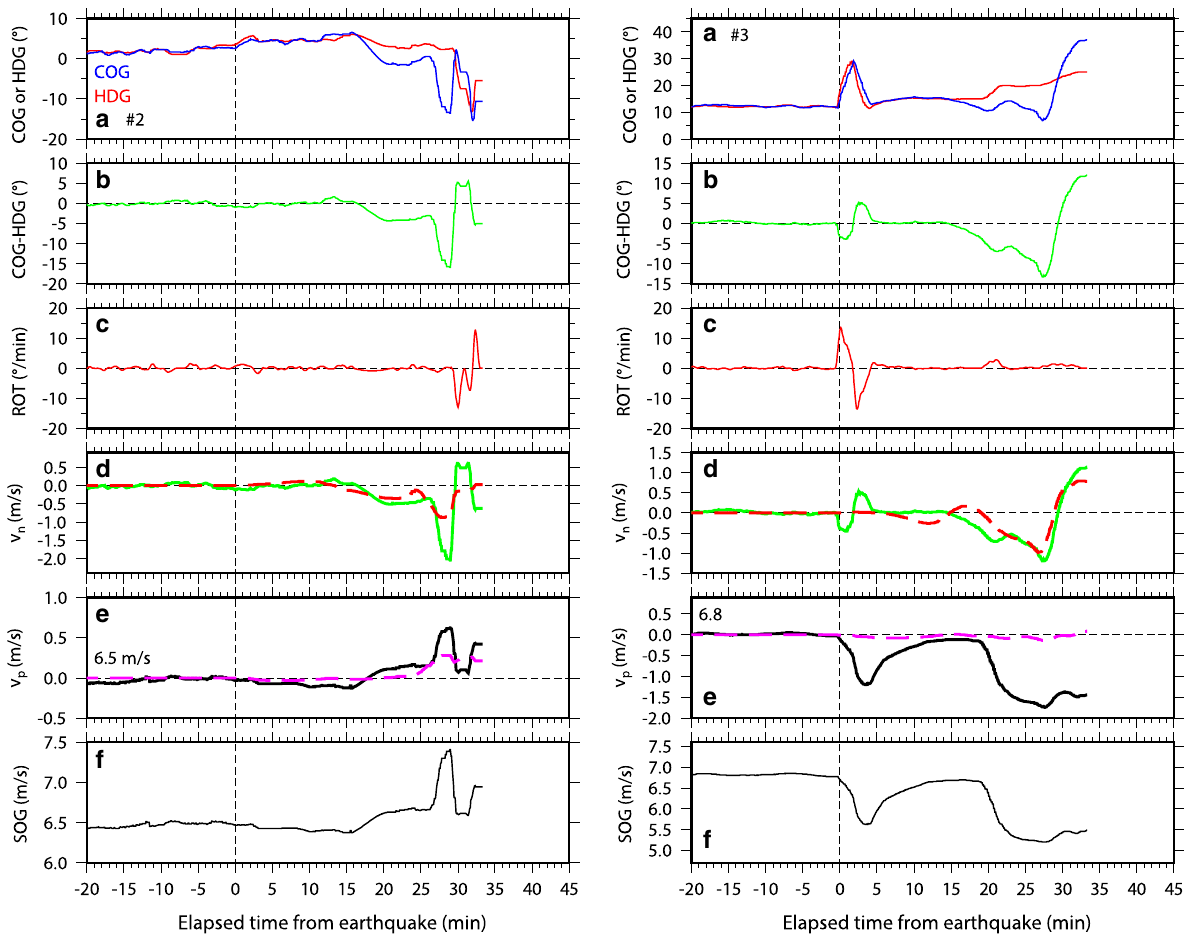
Fig. 4 Time series of AIS data of selected ships (#2, #3, #5, and #11). a COG (blue) and HDG (red), b COG minus HDG, c ROT, d HDG-normal components ( v n ) of ship velocity and tsunami current, e HDG-parallel components ( v p ) of ship velocity and tsunami current, and f SOG. In d and e , solid lines indicate the ship velocity derived from the AIS data, and dashed lines indicate the tsunami current derived from the tsunami wave simulation using the initial condition of Hossen et al. (2015). Each value shown in e is a reference ship velocity (m/s) that is subtracted from